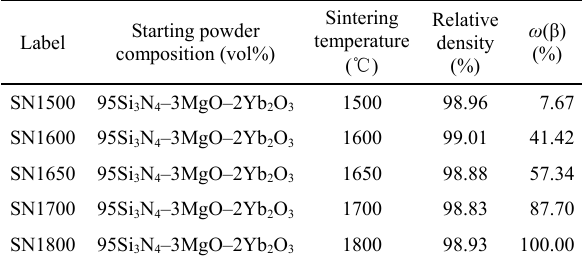
Starting powder compositions, sintering temperatures, relative densities, and contents of β -Si 3 N 4 phase of the sintered Si 3 N 4 ceramics